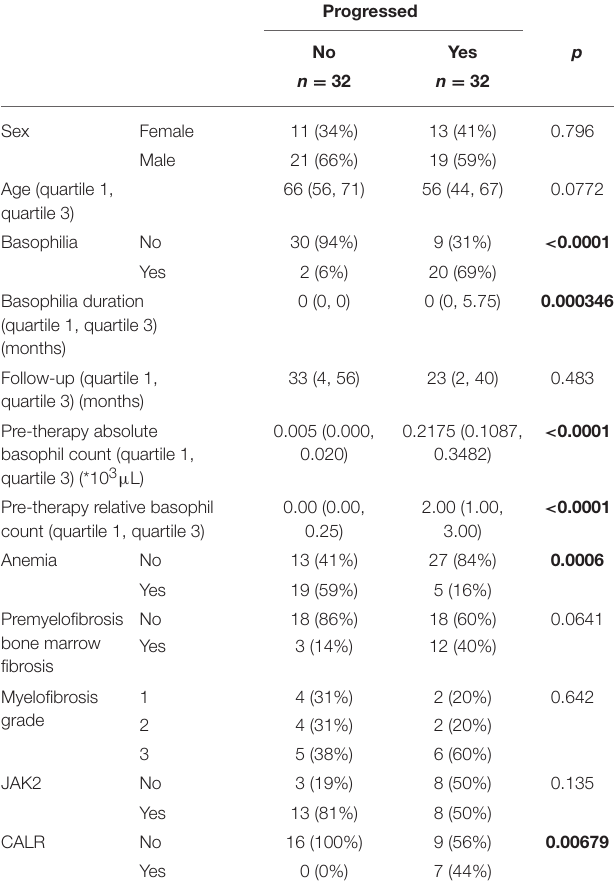
TABLE 1 | Detailed statistical analysis for the correlation of anemia and basophilia for the evolution of primary myelofibrosis towards acute myeloid